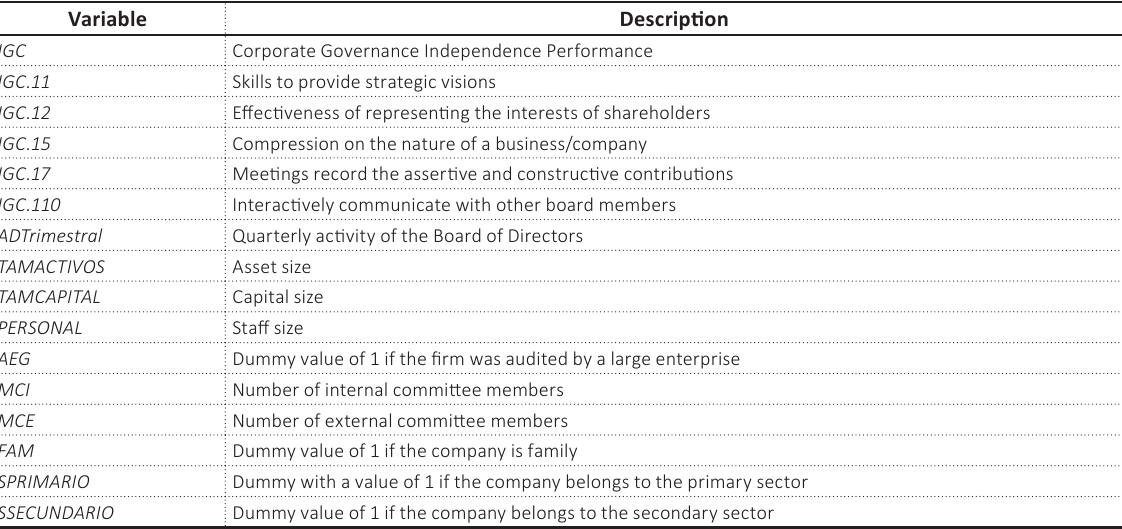
Table 1. Description of